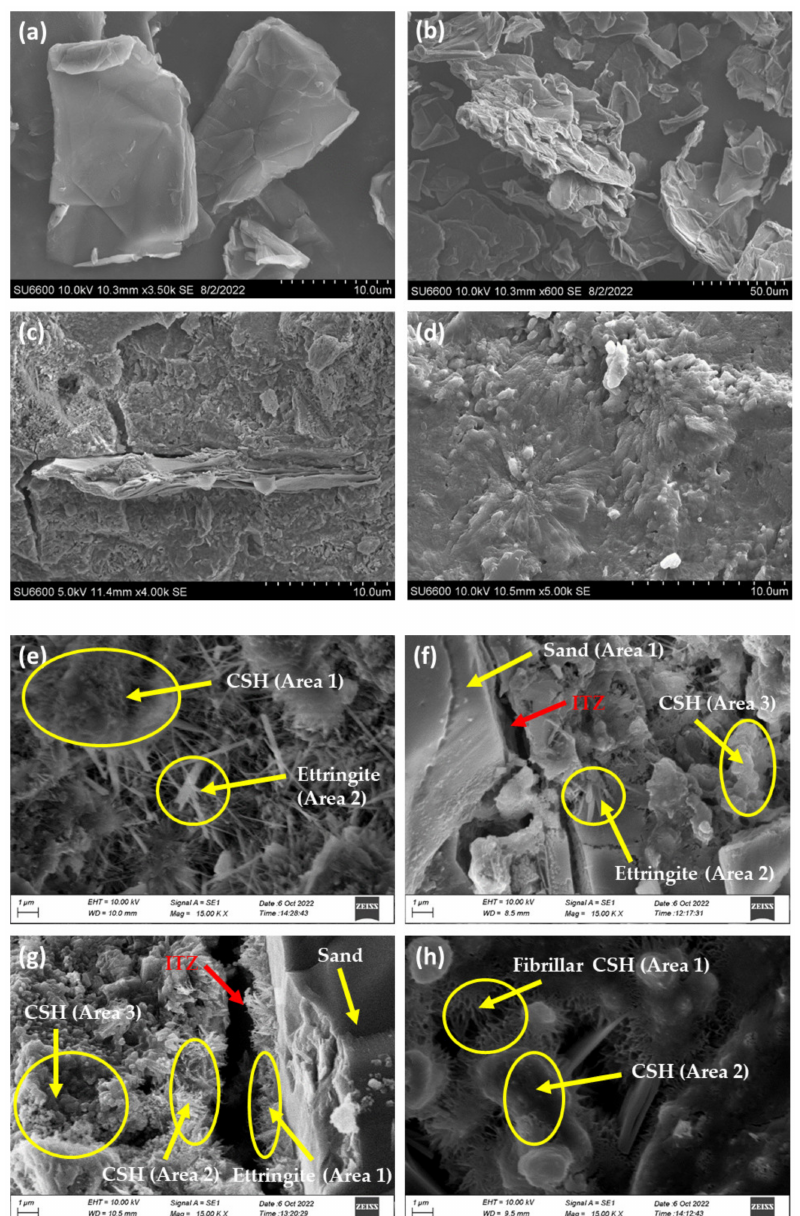
Figure 8. ( a ) GO sheets (at 3500 magnification); ( b ) GO sheets (at 600 magnification); ( c ) SEM of GO added mortar on a fracture surface; ( d ) SEM of GO added mortar from the top view; ( e ) SEM of control mortar; ( f ) SEM of 0.02%GO added mortar; ( g ) SEM of 0.03%GO added mortar; ( h ) SEM of 0.04%GO added